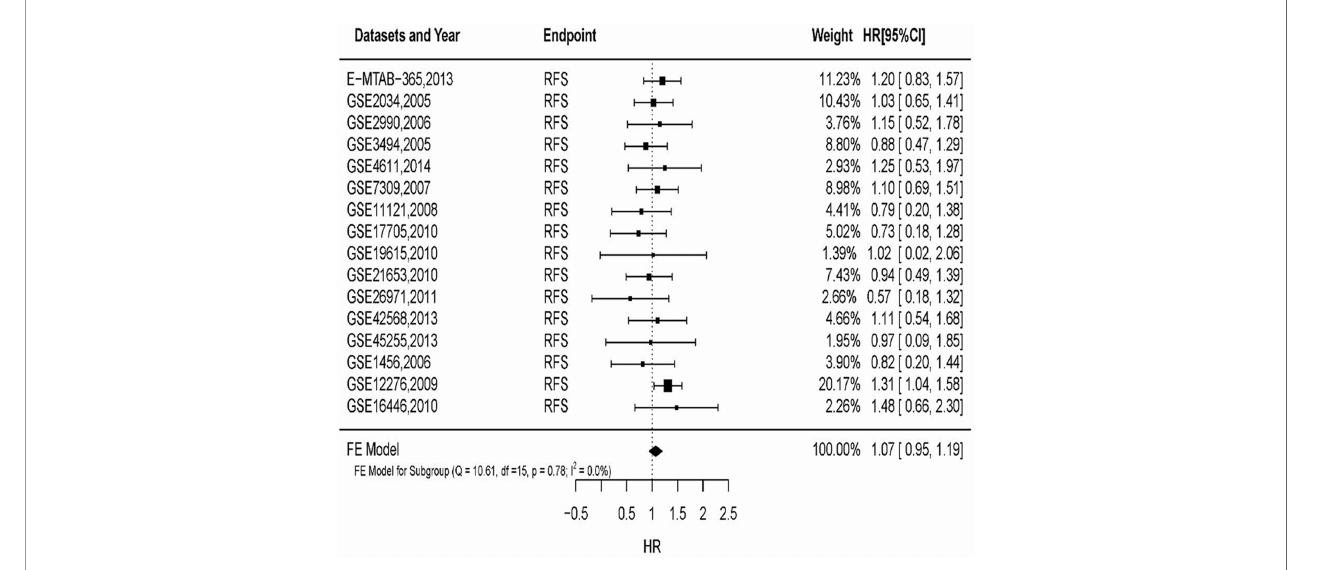
FIGURE 3 | The relationship of MSN expression and endpoints in the GEO datasets, and the results were expressed in terms of hazard ratio (HR) and 95% con fi dence interval